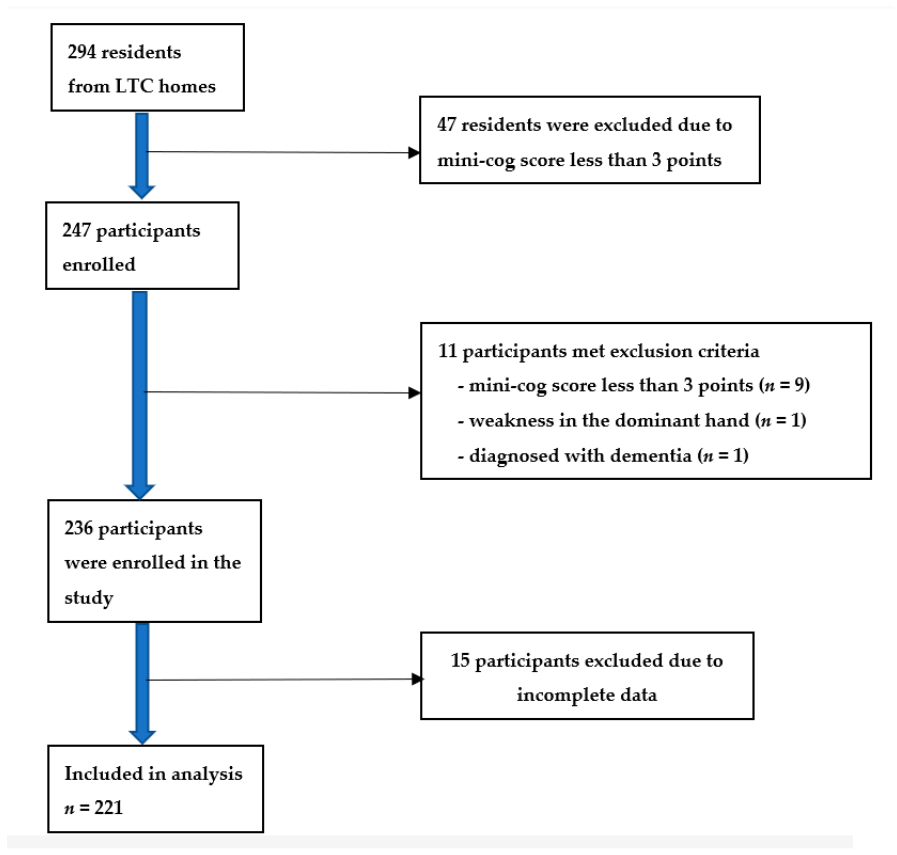
Figure 1. Flowchart of the